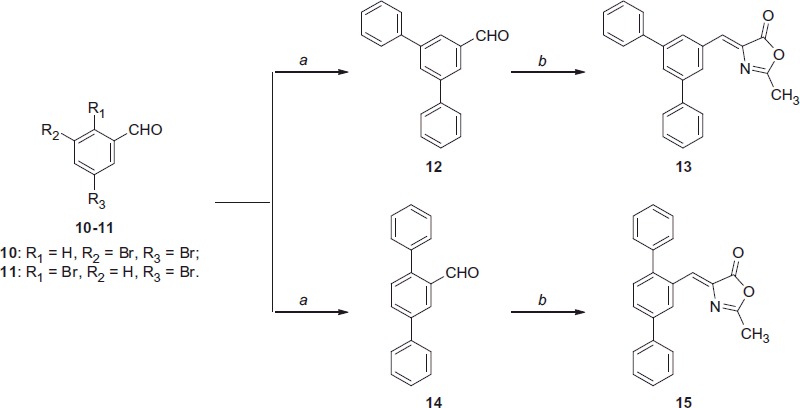
Reagents and conditions: (a) phenylboronic acid, Pd(OAc)2, PPh3, aq. 2 M Na2CO3, toluene, EtOH, 100 °C; (b) N-acetylglycine, Ac2O, CH3COONa, reflux.